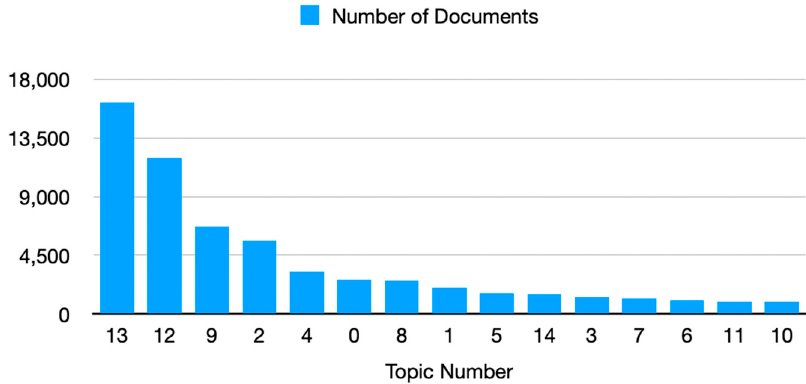
Figure 5. Number of posts in each topic (Source: LinkedIn).